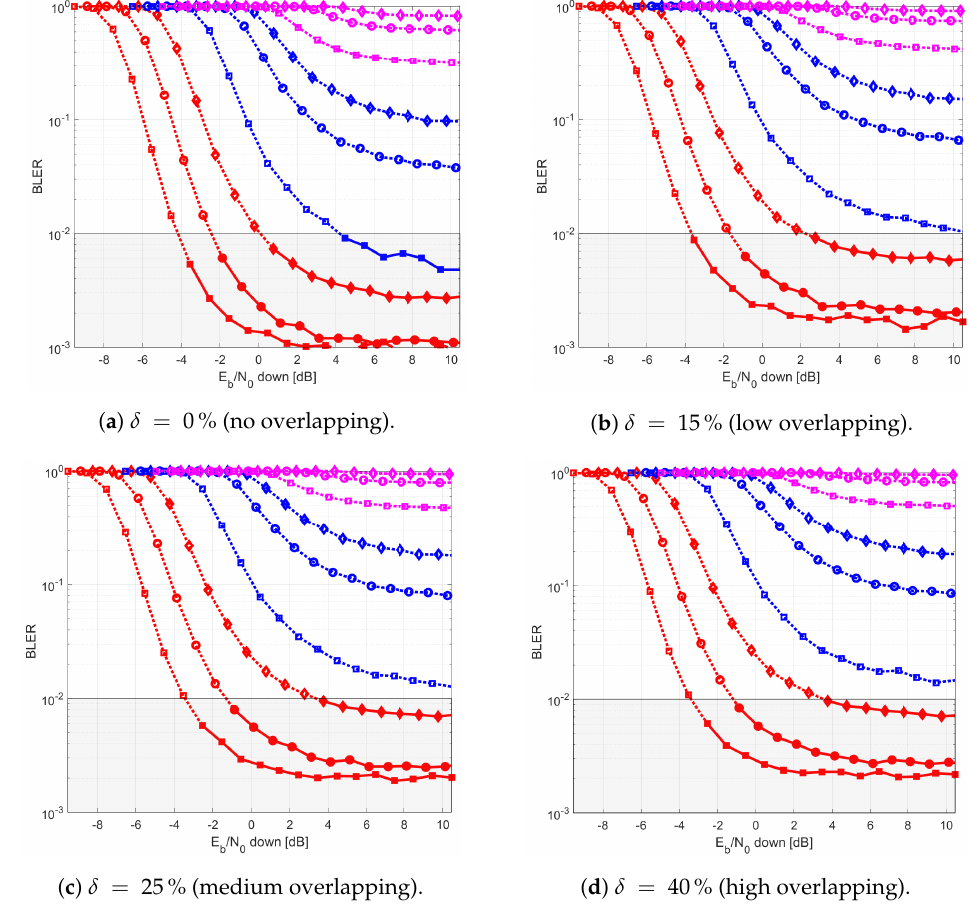
Figure 17. End-to-end BLER versus E b / N 0 in the access link for a NB-IoT frame transmitted over a non-regenerative satellite (Detect-and-Forward) (SNR fl = 15dB). NB-IoT code rates: 0.2222 (red square), 0.259 (red circle), 0.3 (red diamond), 0.444 (blue square), 0.5319 (blue circle), 0.6 (blue diamond), 0.6386 (magenta square), 0.7678 (magenta circle) and 0.8628 (magenta diamond). Solid (dashed-) lines with (un)filled markers: BLER ≤ 10 − 2 requirement (not) fulfilled. Wind speed: v = 21m/s. Diameter of telescope aperture: W 0 =